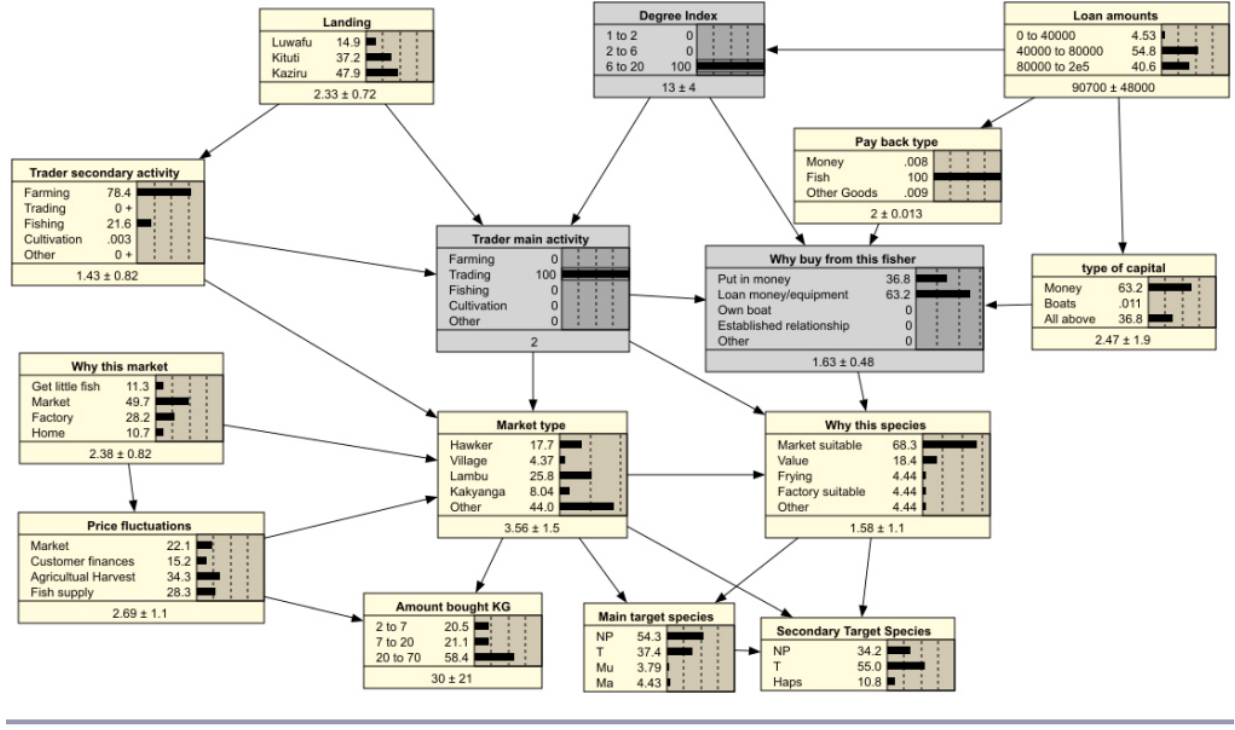
Fig. 6 . Bayesian Belief Network of the trader responses when the patron-client scenario is selected. The probabilities of the grey nodes are set at 100% for a selected category (see Table 3), while the probabilities for the remaining nodes are recalculated given the restricted probability